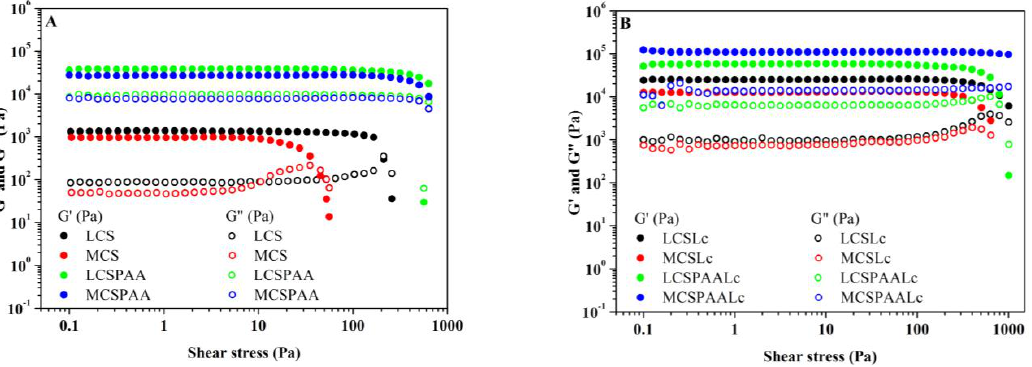
Figure 2. Effect of shear stress on storage (G’) and loss (G”) moduli for the studied microspheres: ( A ) before immobilization procedure and ( B ) after immobilization procedure. ( A ) before immobilization procedure and ( B ) after immobilization